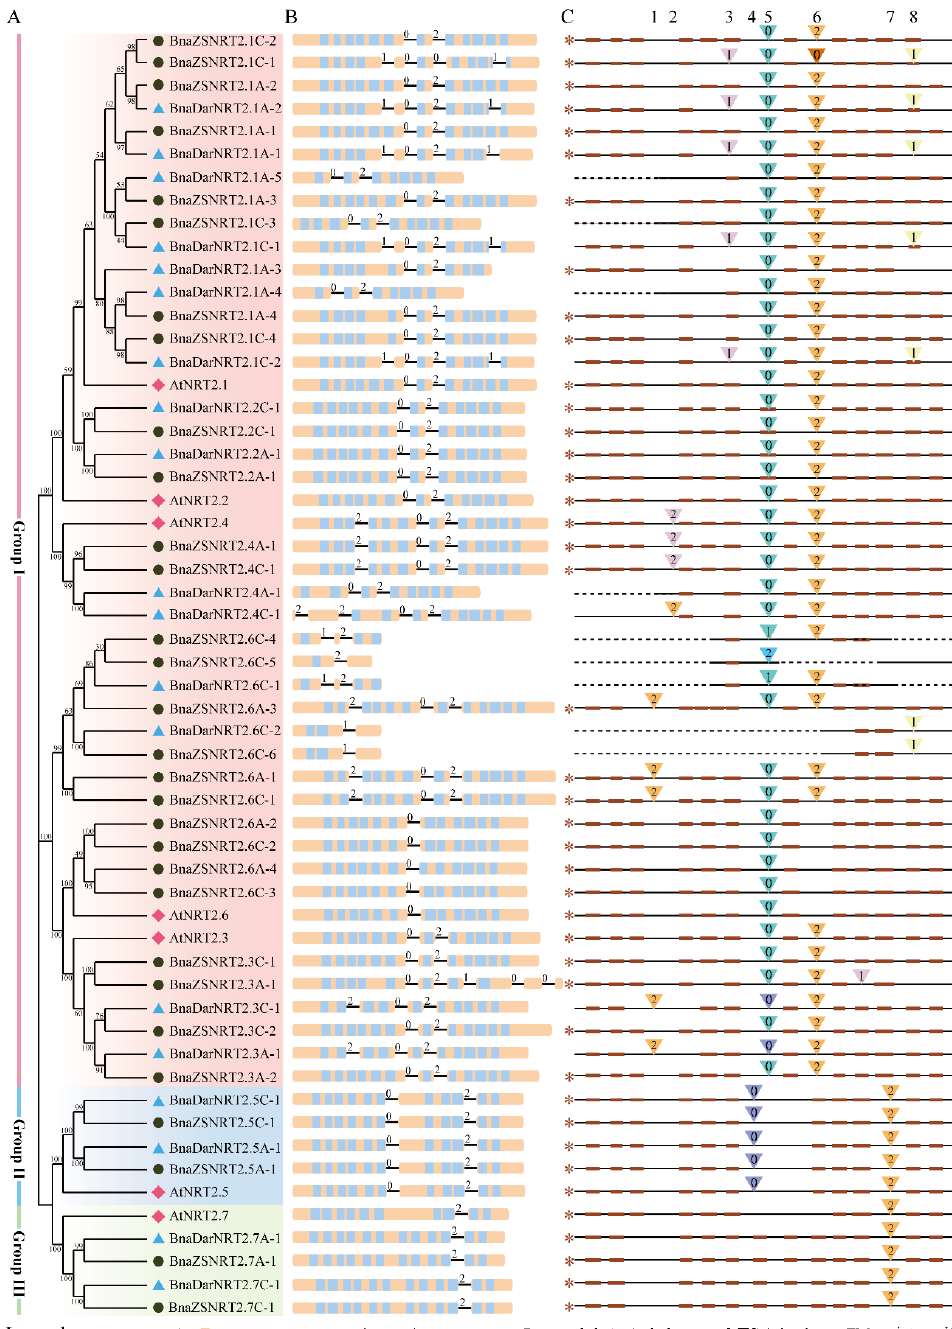
Figure 1. Phylogenetic tree and sequence structures of the candidate NRT2s in B. napus and Arabidopsis . ( A ) Neighbor-joining (NJ) phylogenetic tree of NRT2s in B. napus and Arabidopsis . Different background colors represent different groups. ( B ) Gene structures of NRT2s in B. napus and Arabidopsis . Exons are shown by yellow boxes, transmembrane (TM) domains are shown by blue boxes, and the lines between the colored boxes correspond to the introns. Numbers 0, 1, and 2 represent introns phase 0, 1, and 2, respectively. ( C ) Intron insertion patterns of NRT2s in B. napus and Arabidopsis . The top numbers (1 – 8) indicate the orders of the 8 conserved intron sites. The triangles represent different intron insertion sites. Each column (triangle with the same color and number) represents the same intron insertion site and phase. The dashed lines represent the severely missing sequences of